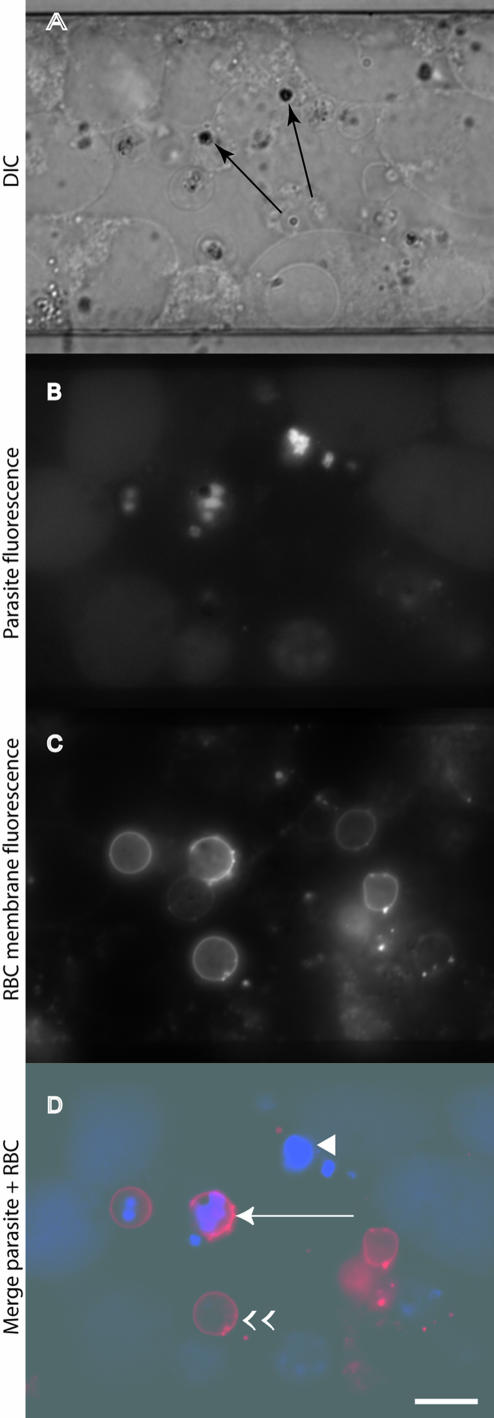
Phagocytosis of iRBCs under Flow(A) Differential interference contrast image of RAW macrophages in a 50-μm channel after lysis of attached RBCs. Arrows show the malarial pigment, hemozoin.(B) Fluorescence image of parasite nuclei ingested by macrophages.(C) DiIC staining of RBC membranes.(D) Parasite DNA fluorescence (blue) and RBC membranes (red) merged. Long arrow shows ingestion of entire iRBC, arrowhead shows ingestion of only the parasite, and double arrowhead shows ingestion of RBC without parasite.Scale bar = 10 μm.